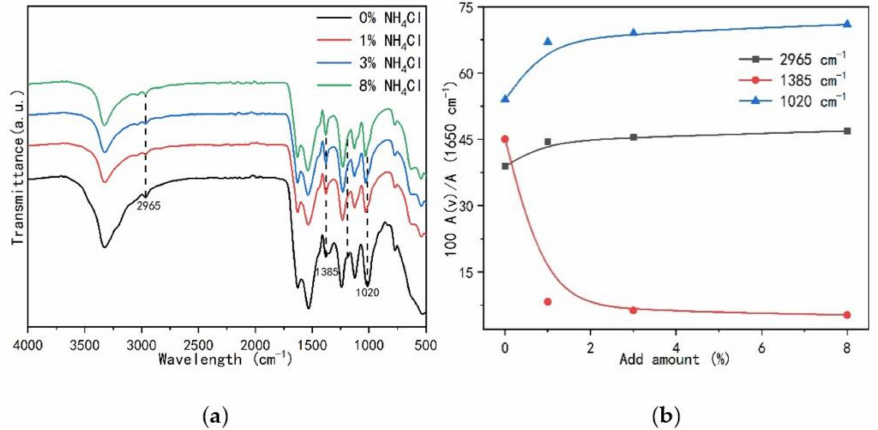
Figure 13. Comparison of FT-IR spectra of UF resin with a molar ratio of 1.0 under different curing agent content. ( a ) Three absorption bands (dashed lines) used for quantitative analysis in FT-IR; ( b ) the three absorption bands are based on the quantitative results of the carbonyl group at 1650 cm − 1